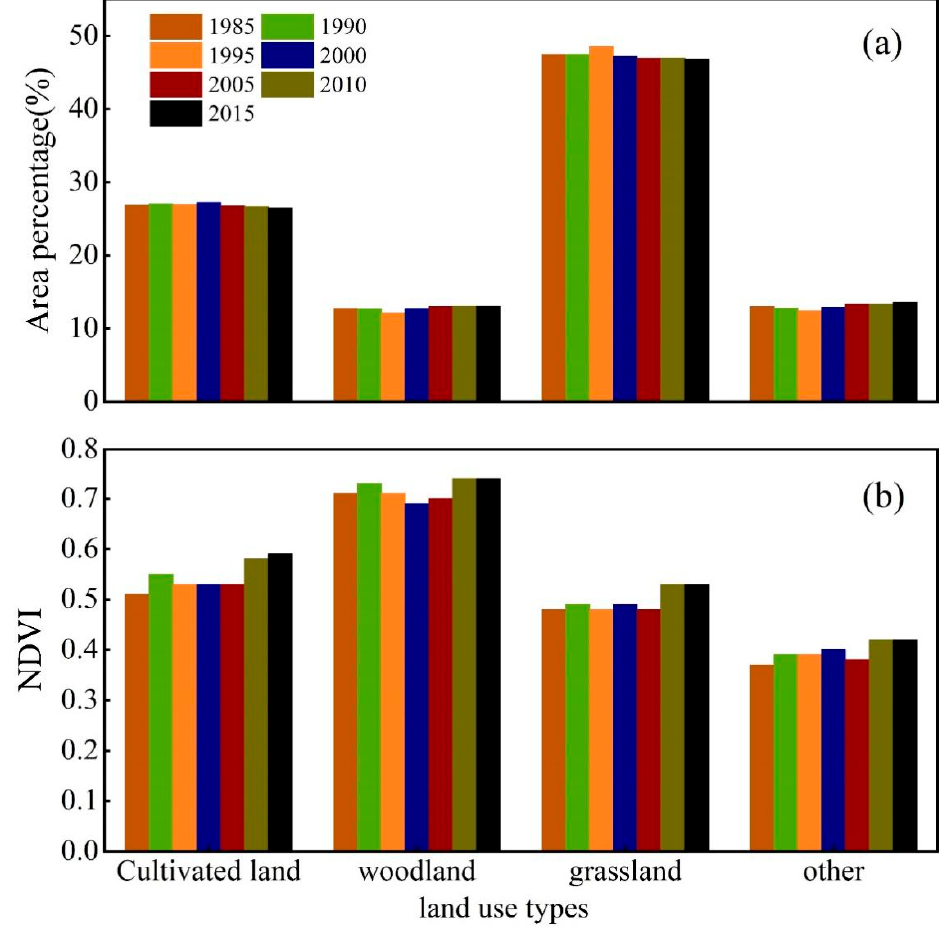
Figure 12. Temporal trend of land use types in the Yellow River Basin (YRB). ( a ) Proportion of land use area (%) and ( b ) the normal difference index (NDVI).